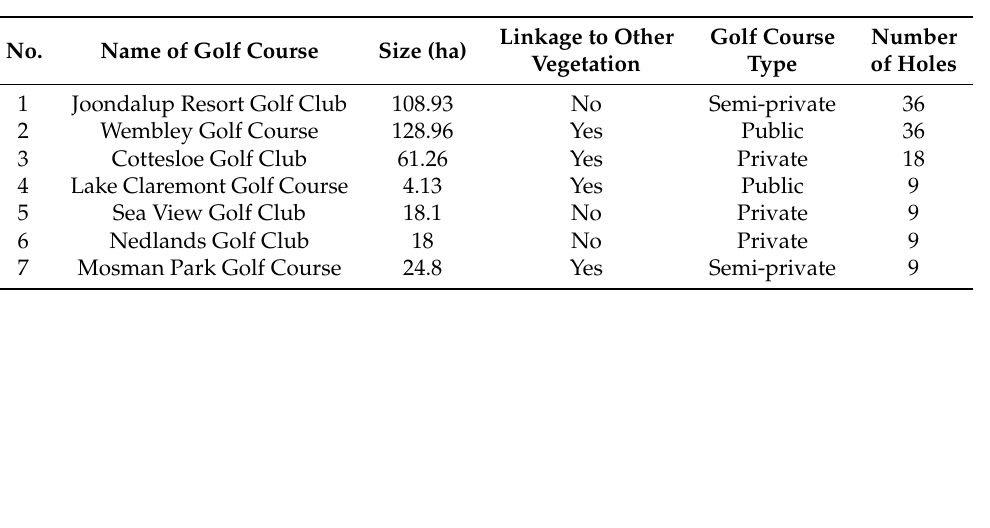
Table 1. Key characteristics of the seven golf